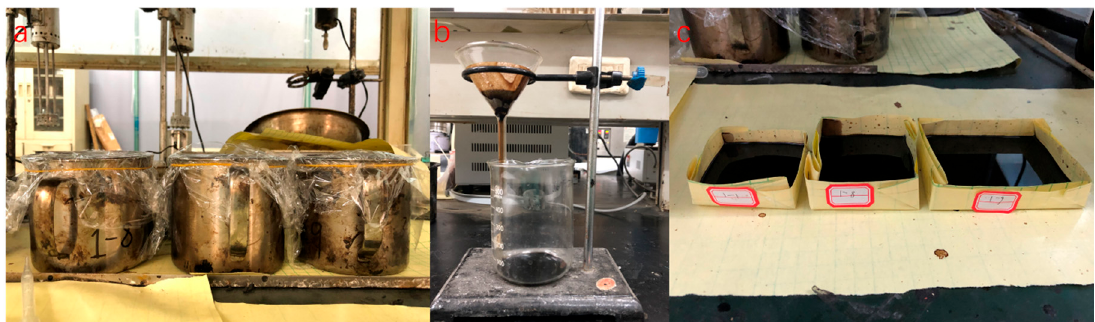
Figure 9. Laser particle size analysis of limestone fillers.